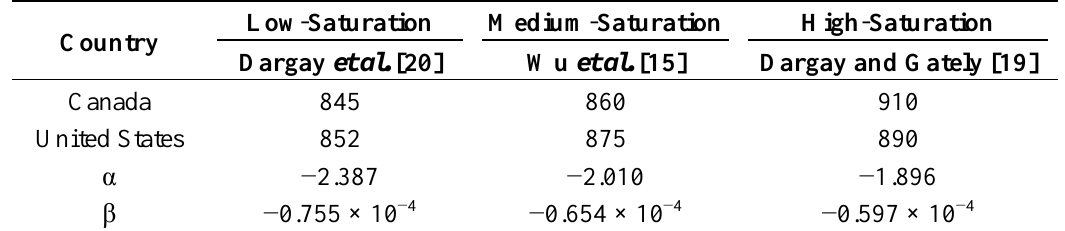
Table 6. Varying vehicle saturation levels and curvature parameters in the Gompertz function.